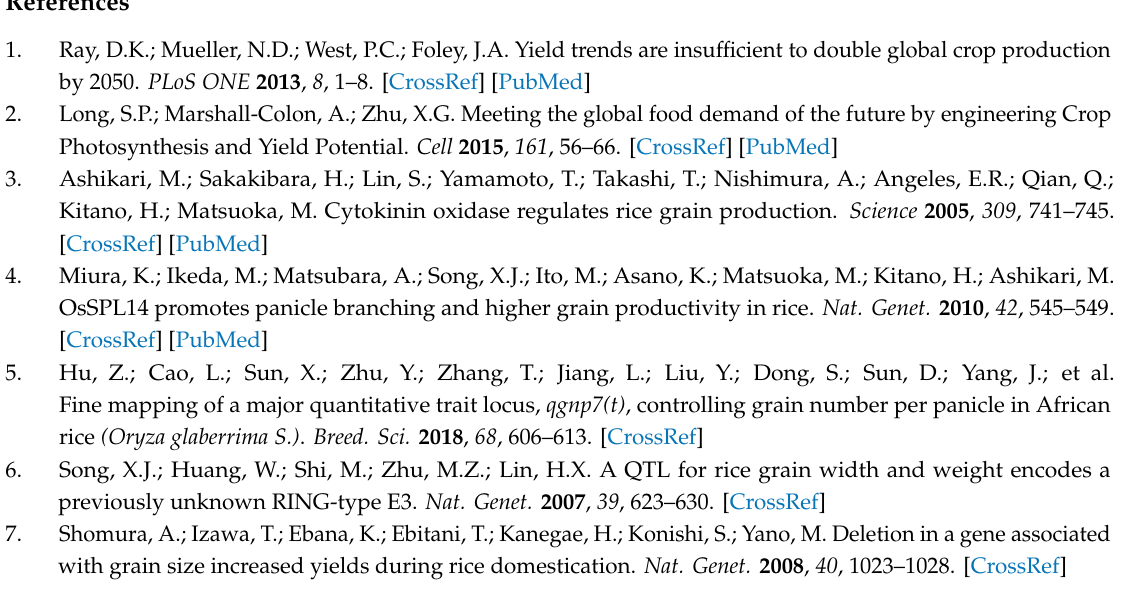
Figure S1: The number of selected and evaluated Fukuhibiki M 2 plants and their plant yields; Figure S2: Yield trials of M5 FukuhibikiH6 compared with Fukuhibiki in paddy field with heavy fertilizer application in 2017; Figure S3: Thermo-camera observation of MochidawaraH1 (middle) and Mochidawara (left) at maximum tillering stage in paddy field in Ibaraki, Japan, in 2016. Note: lower leaf temperature MochidawaraH2 was discarded because of its lower yield; Table S1: Plant yields of Fukuhibiki M 3 lines in 2015 (extracted); Table S2: Yield trial of mutants in paddy field with heavy fertilizer application in Ibaraki, Japan, 2016; Table S3: Yield trial of mutants in Ibaraki, Japan, in 2017; Table S4: Analysis of variance (ANOVA) test for grain yield of FukuhibikiH6